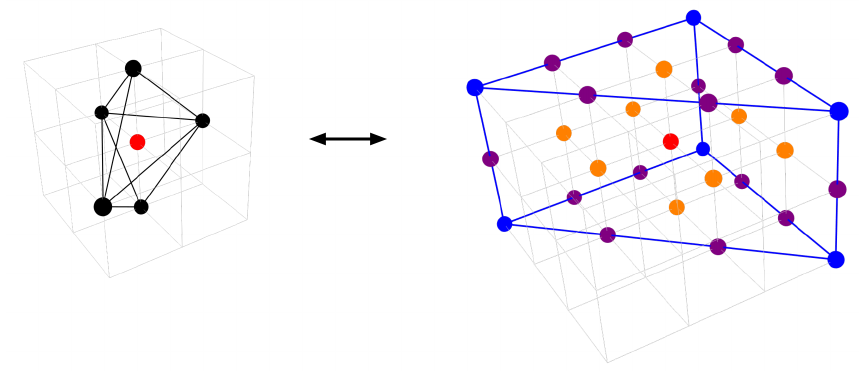
Figure 1 . The toric diagram for M 3 , 2 ( P 2 × P 1 ) and the corresponding dual polytope. Both are reflexive polytopes in dimension 3 with the single interior point highlighted in